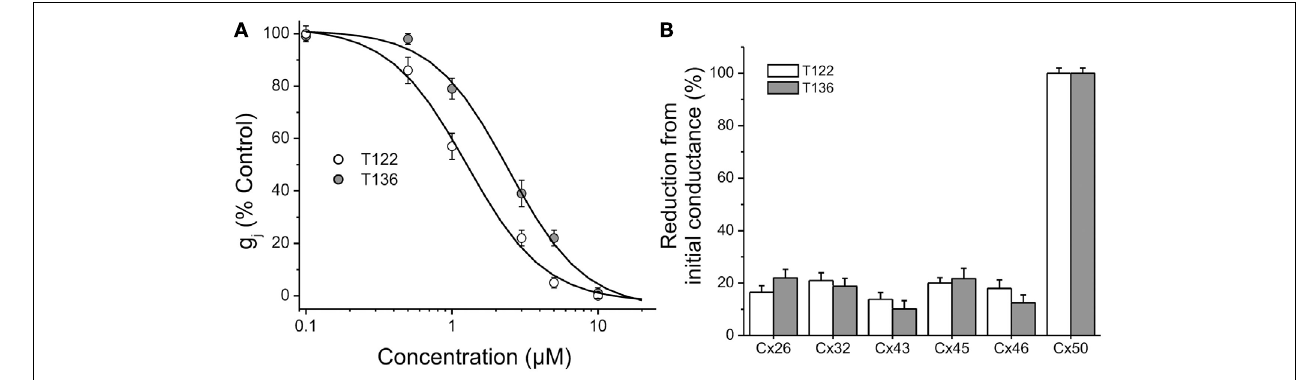
values are indicated in the text. Each cell pair was exposed to only a single concentration. (B) Bar graph illustrating thatT122 (10 μ M) andT136 (10 μ M) has no significant effect on Cx26, Cx32, Cx43, Cx45, and Cx46 gap junction channels. Each bar represents the mean ± SEM of four to six cell pairs.